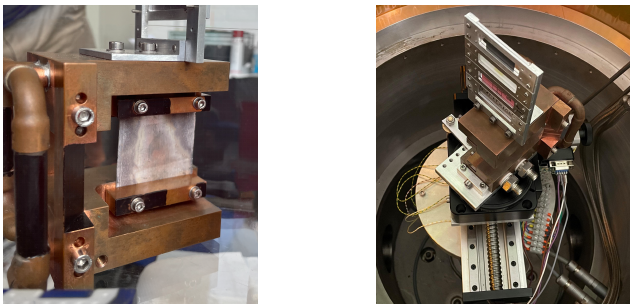
Figure 3. High-luminosity lithium target used for the hypertriton experiment. Left: The lithium sheet has a thickness of 2.5g / cm 2 in beam direction. In the left part of the setup, pipes for the cooling liquid can be seen for the optimal removal of heat from the lithium sheet. Parts of the copper frame are painted with infrared absorbing black paint to prevent undesired reflections in the camera pictures. Right: The copper frame mounted inside the target chamber, additional targets on top. Below the frame, a rotary and a linear stepper motor are